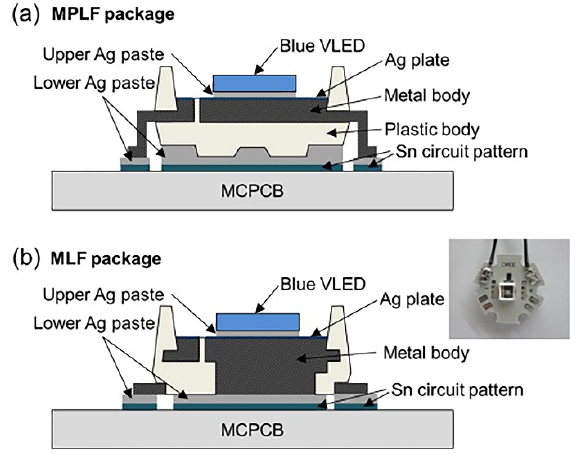
Figure 2. Schematic diagram of blue VLEDs mounted on ( a ) a lead frame with a metal/plastic body (MPLF package) and ( b ) a lead frame with a metal body (MLF package) [21].